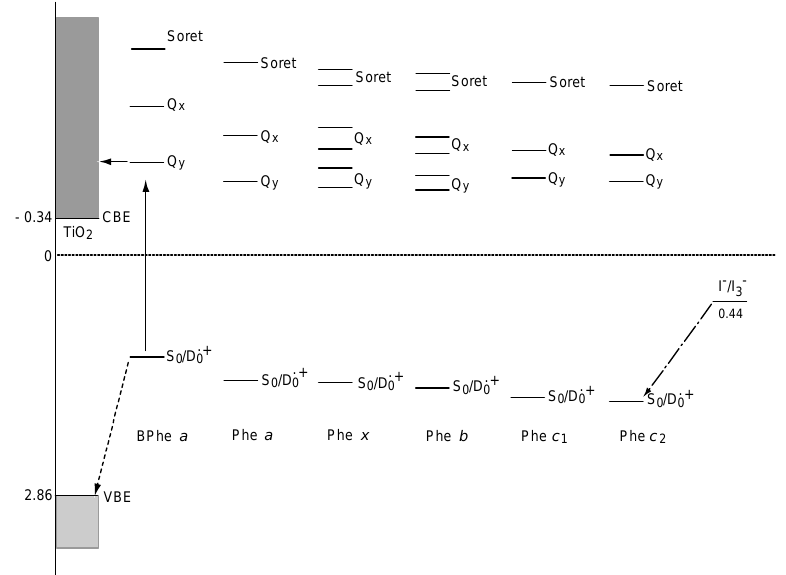
Figure 39. Relative arrangement of the redox ground-state (S and Q ) levels of Phe sensitizers in reference to those of the valence- excited (Soret, Q x y band-edge (VBE) and the conduction-band-edge (CBE) of TiO from [20] © 2008, American Chemical